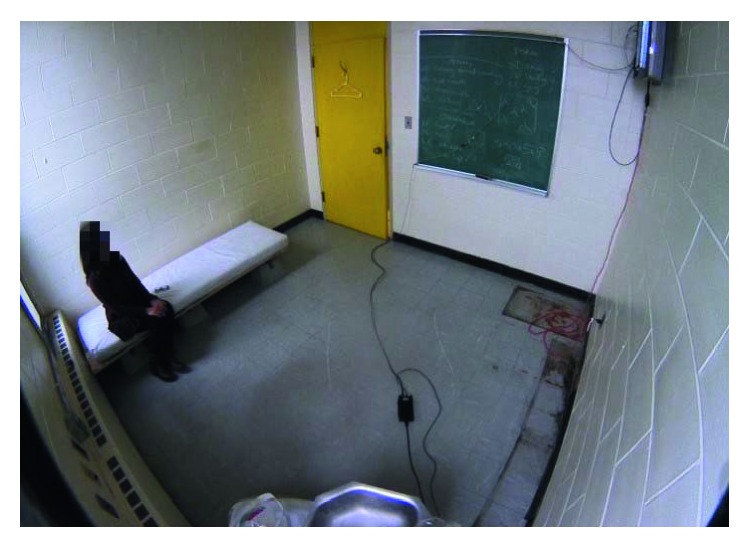
Experiment setup.